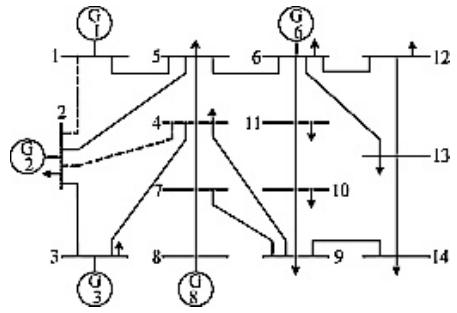
Figure 3. The I n stitute of Electrical and Electronics Engineers (IEEE) 14 node system. Figure 3. The Institute of Electrical and Electronics Engineers (IEEE) 14 node